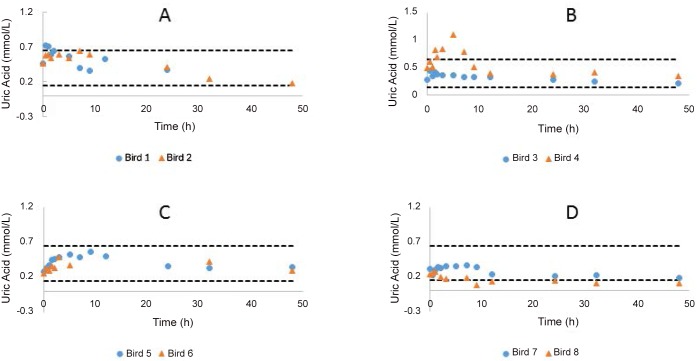
Changes in uric acid concentration for the individual birds treated with carprofen (A), flunixin (B), phenylbutazone (C) in comparison to the controls (D).The dotted lines represent the population upper and lower tolerance.